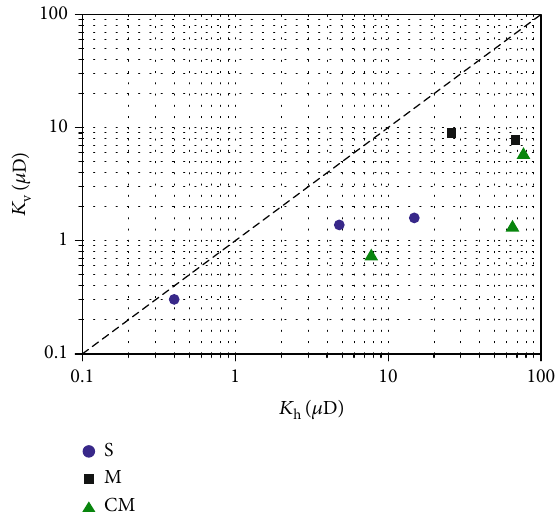
Figure 15: Klinkenberg-corrected permeability coe ffi cients measured parallel ( K h ) and perpendicular ( K v ) to